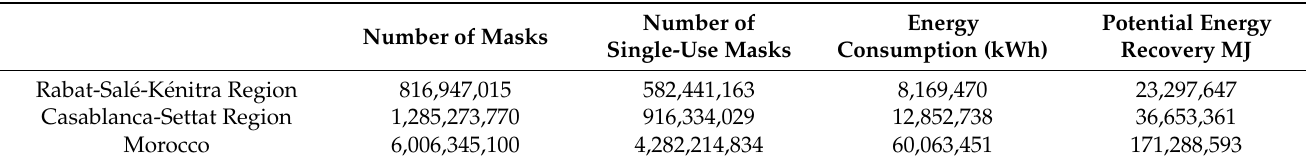
Table 4. Annual energy consumption and potential energy recovery for the studied regions: Rabat-Sal é -K é nitra and Casablanca-Settat, and Morocco according to the results of the present study. Number of Number of Masks Single-Use